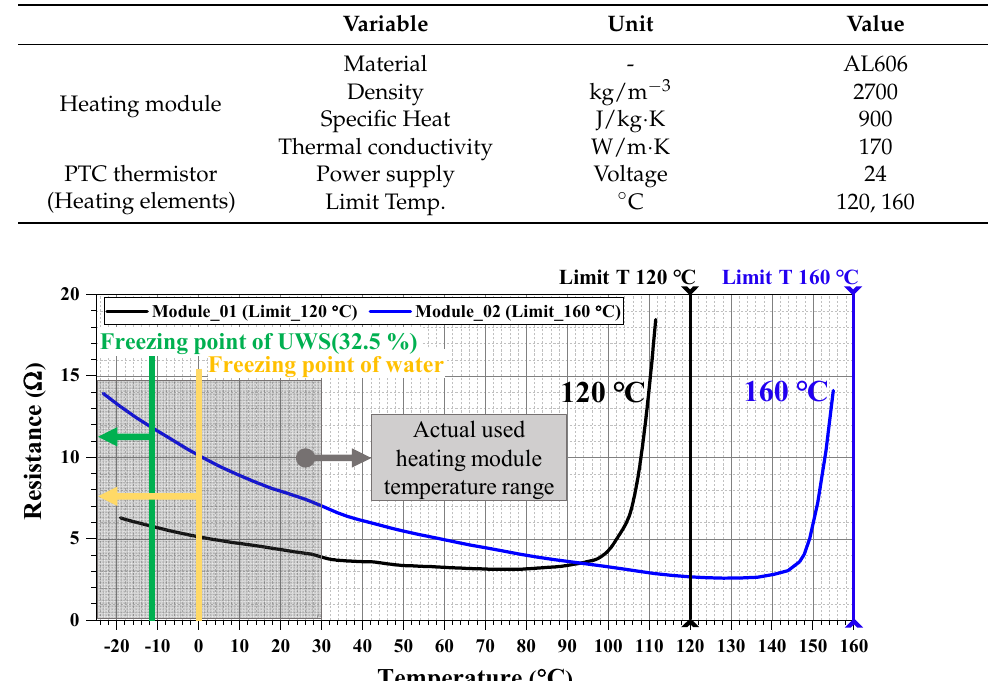
Figure 3. Heating module and heating elements. Table 1. Specifications of heating module and PTC thermistor.